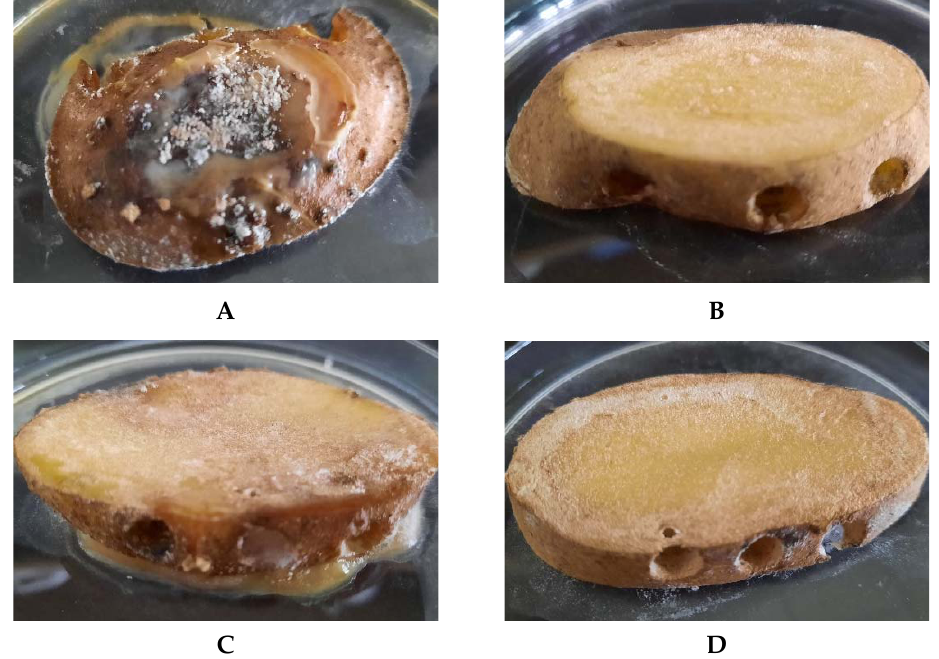
Figure 8. Inhibition of Streptomyces scabiei ( A , B ) and Pectobacterium carotovorum ( C , D ) infestation